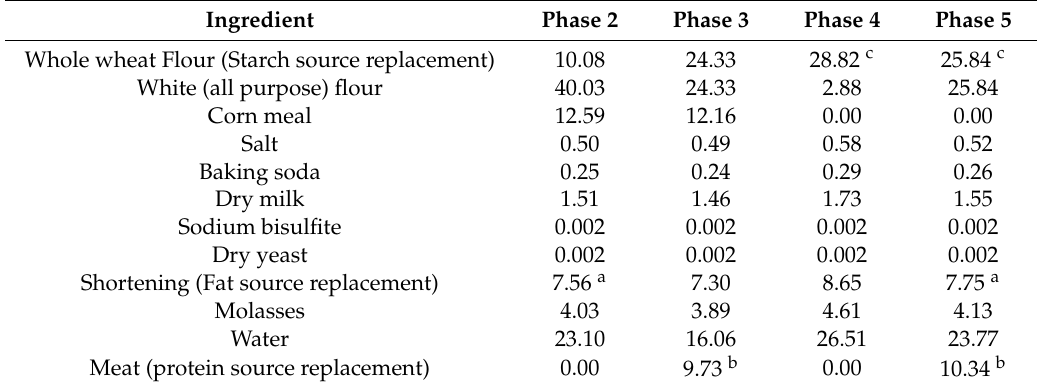
Table 1. Ingredient % composition for treats evaluated by dogs in phases 2–5